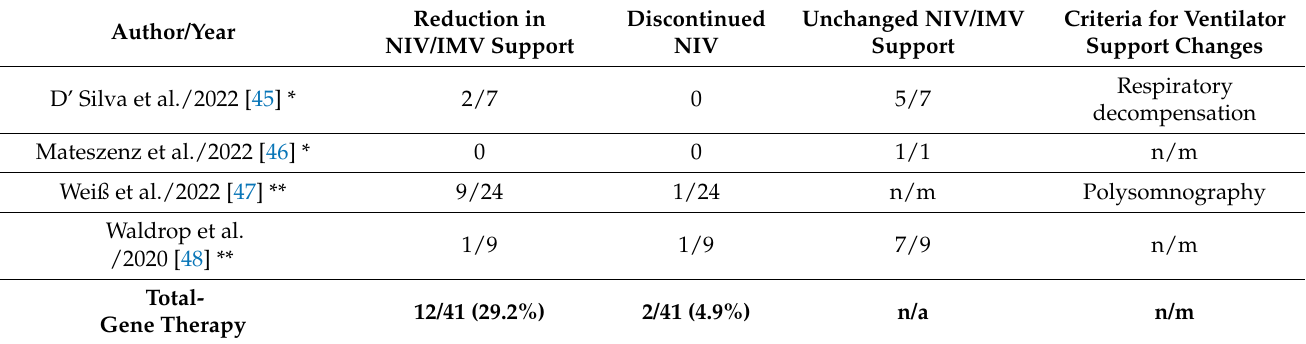
Table 5. Changes in ventilatory support requirements following treatment with gene